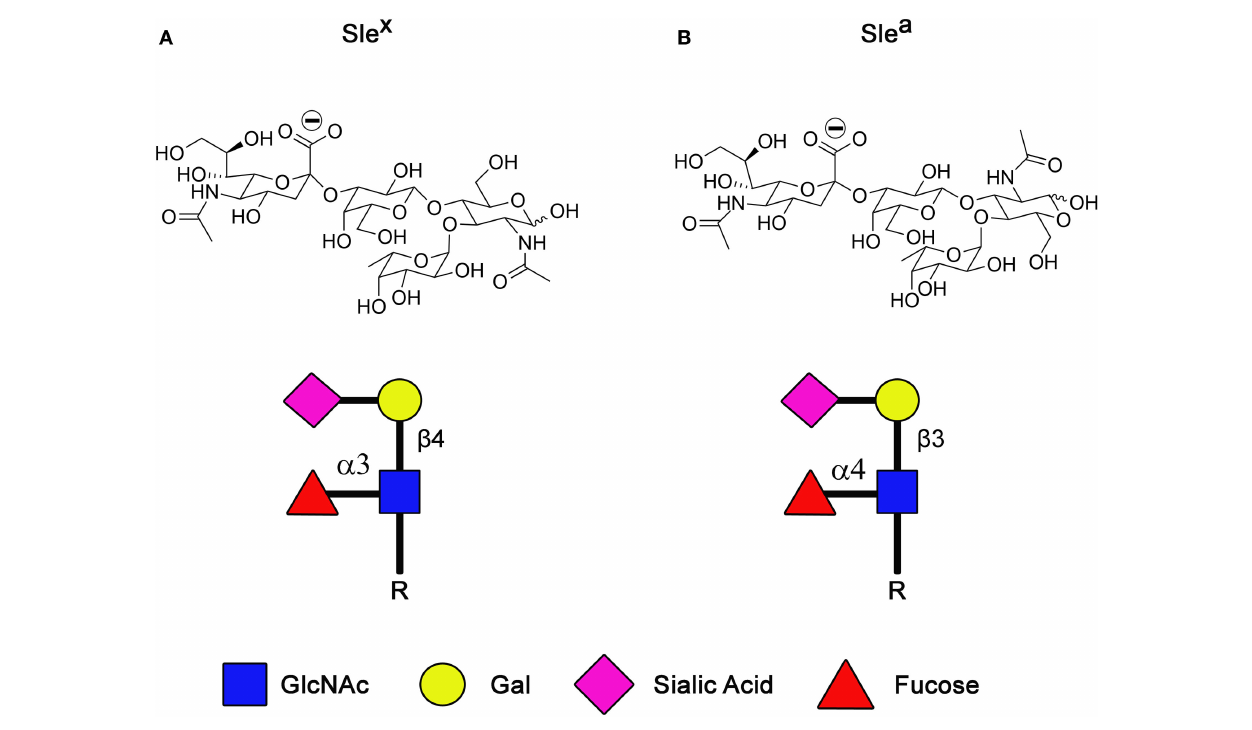
FiGURe 2 | Structure of SLe x (A) and its structural isomer SLe a (B)